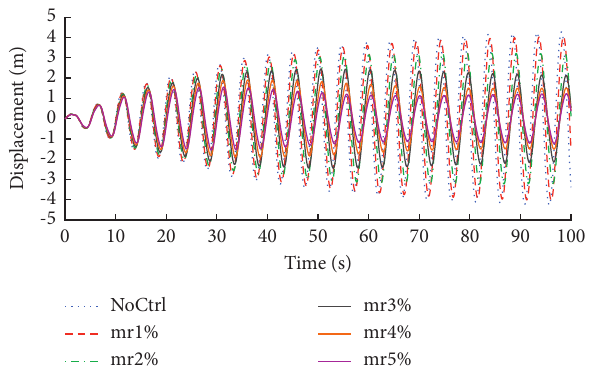
Figure 12: : Time history of the displacement of the SCR implemented with PTMD of mass ratio from 1% to 5% at oceanic condition